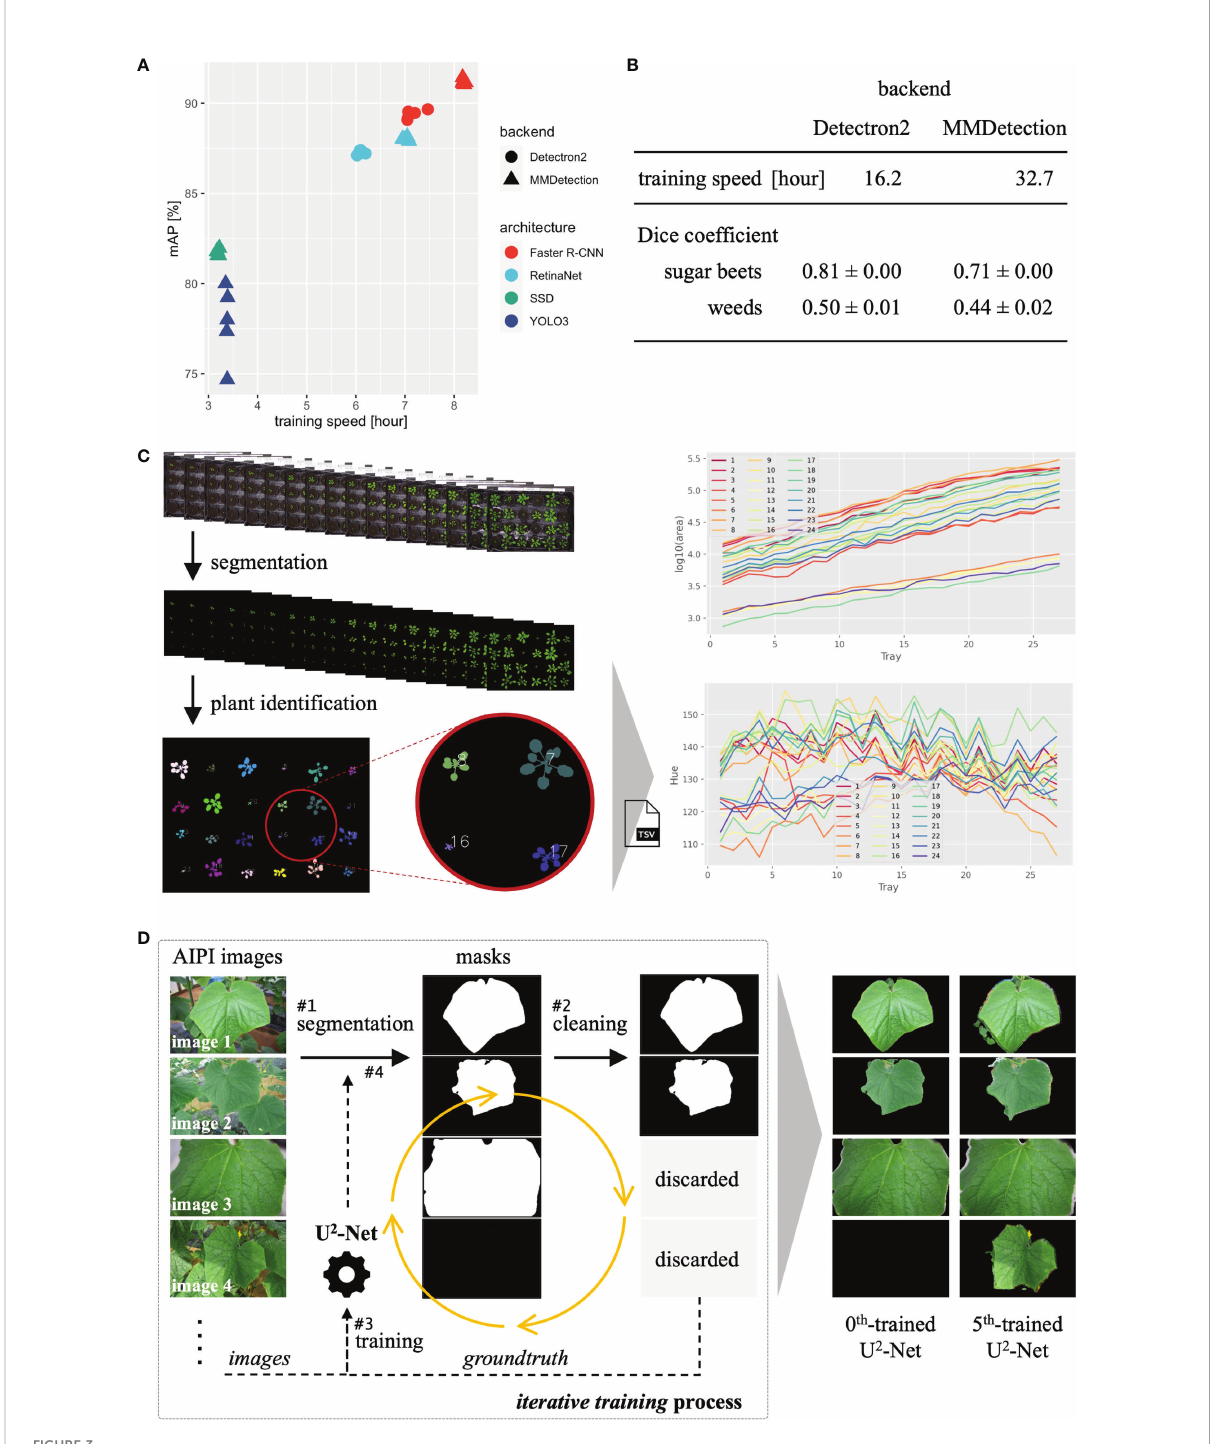
FIGURE 3 Results of three case studies. (A) Training time and validation mAP of object detection. (B) Training time and validation mAP of instance segmentation. (C) The process and analysis result (projected area and color hue) of plant segmentation with time-series plant images. (D) Processes and sample results of iterative training of U 2 -Net for leaf